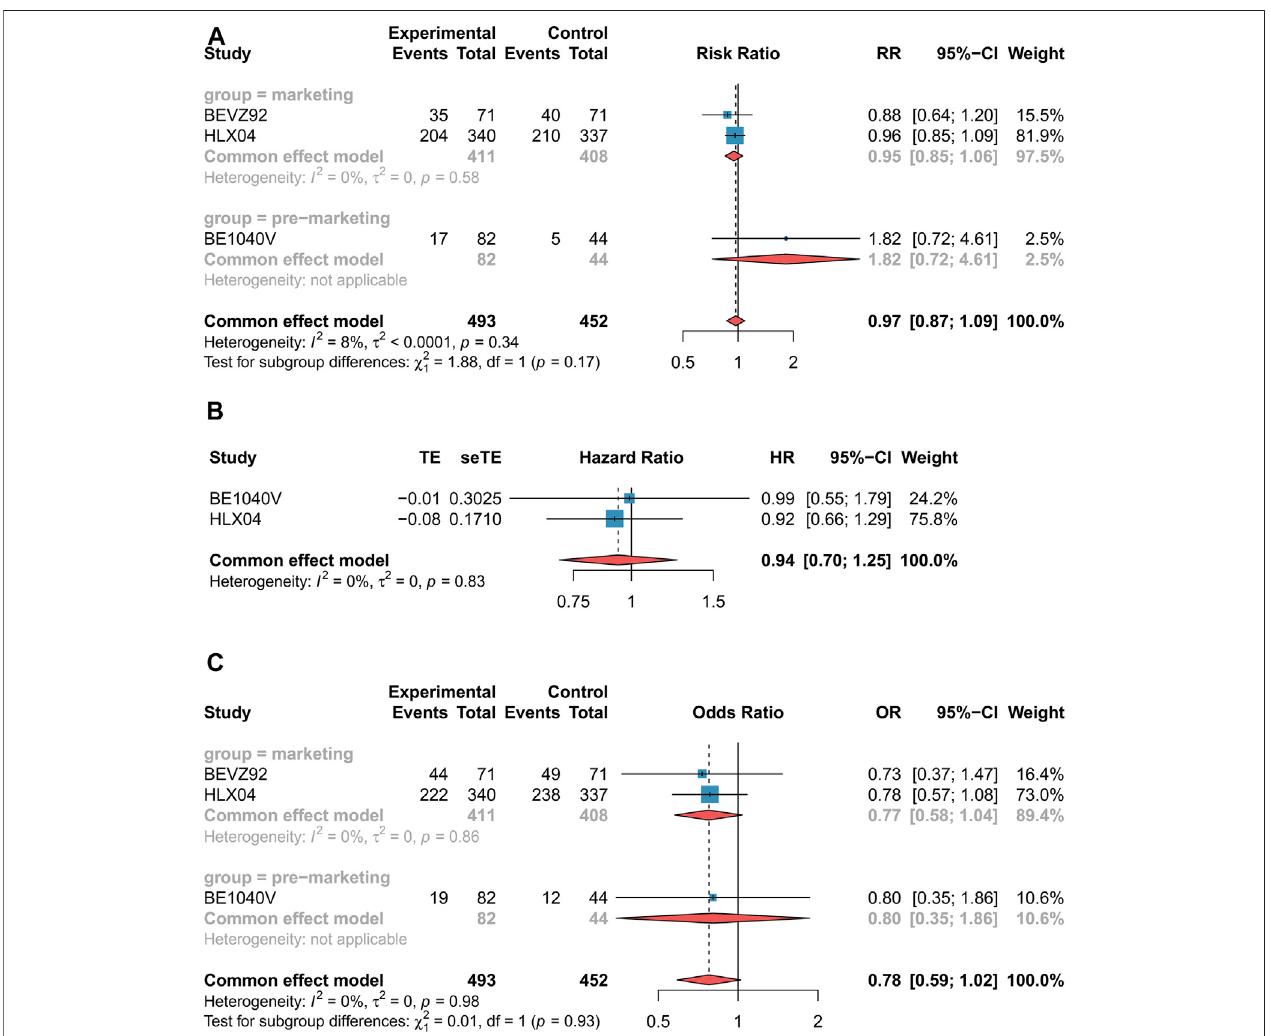
FIGURE 4 | Forest plots of outcomes for colorectal cancer patients. (A) Objective response rate. (B) Overall survival. (C) Incidence of grade 3 – 5 adverse events. Thesedrugsweregroupedbymarketing.ThemarketingdrugincludedBEVA92andHLX04,whileBE1040Vbelongedtothepremarketingdrug.Objectiveresponserate was measured using risk ratio (RR), overall survival was measured using hazard ratio (HR), and incidence of grade 3 – 5 adverse events were measured using odds ratio (OR).IftheRRvaluewashigherthan1,itfavoredthebiosimilargroup;otherwise,itfavoredthereferencebiologicsgroup.IftheHRvaluewasmorethan1,itfavored thebiosimilargroup;otherwise,itfavoredthereferencebiologicsgroup;IftheORvalueishigherthan1,itfavoredthereferencebiologicsgroup;bycontrast,itfavoredthe biosimilars group. CI, con fi dence interval; OR, odds ratio; HR, hazard ratio; and RR, risk ratio.